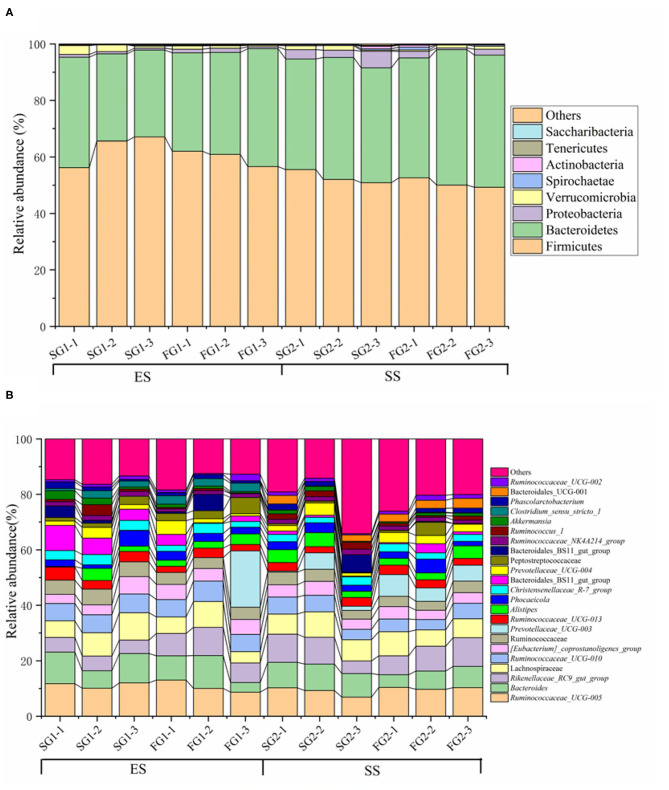
The rumen microbiome composition at phylum (A) and genus (B) level. Only those with mean relative abundance more than 0.1% (for phyla) or 1% (for genera) are shown.